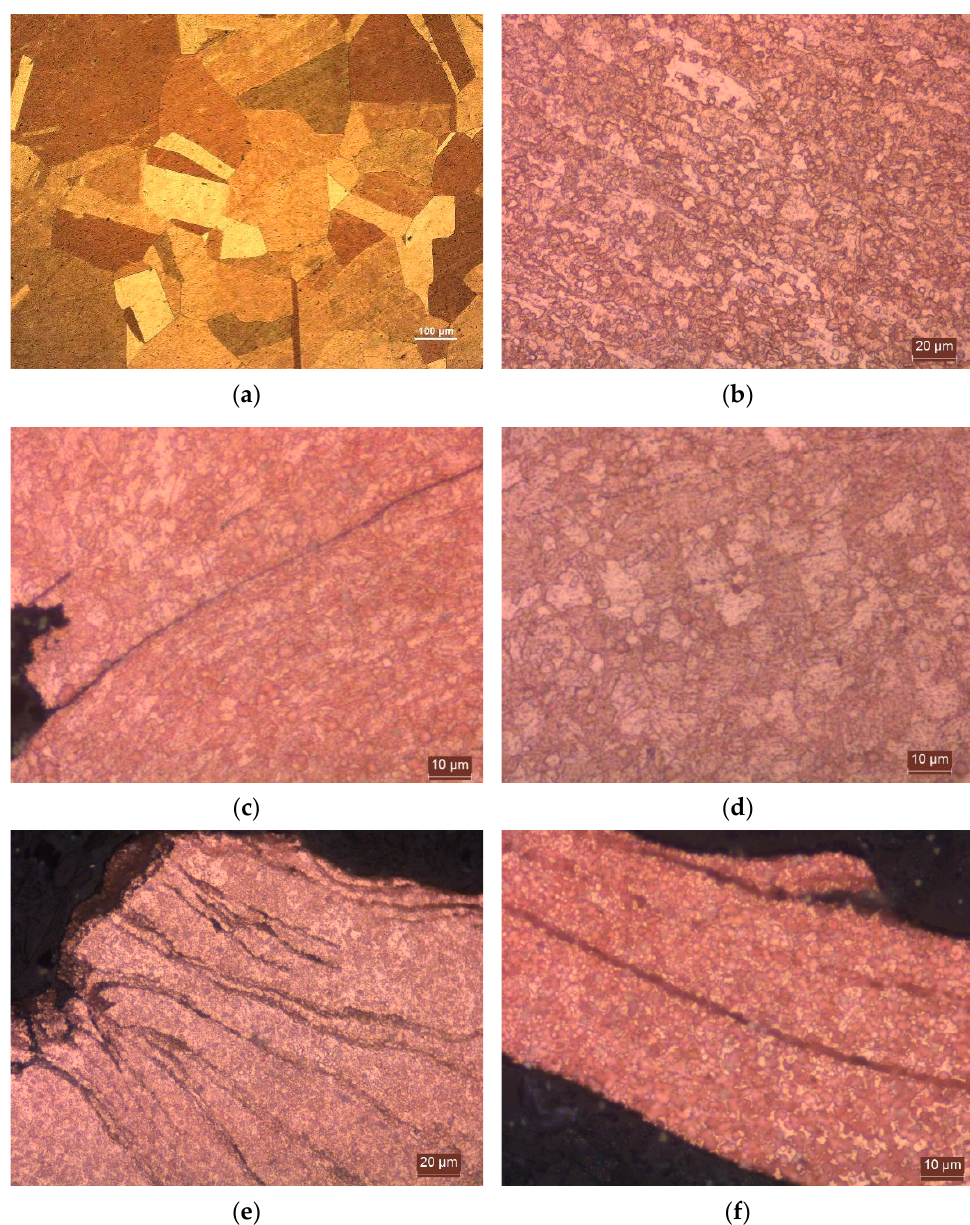
Figure 13. Microstructural morphology of OFHC-Cu. ( a ) Initial structure; ( b – d ) Slug structure; ( e , f ) Jet structure.